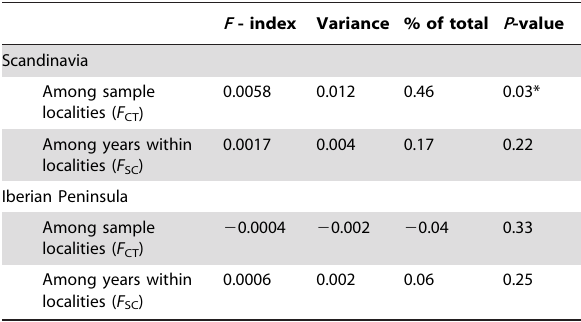
Table 5. Results of AMOVA analysis [33] partitioning genetic variability among and within localities (temporal replicates) within the Scandinavian and the Iberian